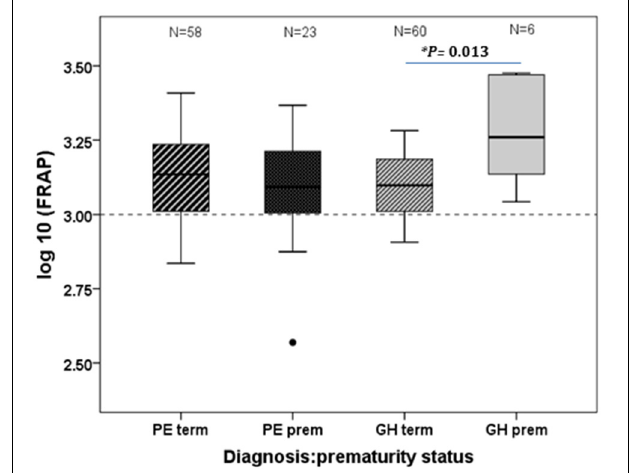
FIGURE 2 | Antioxidant status, measured as FRAP, shown by prematurity status in the PE and GH diagnostic groups. Note the log 10 scale. Significantly higher antioxidant status in the GH preterm than the GH term group ( P = 0 . 013). The dotted line is the median reference value for non-pregnant females within this assay.